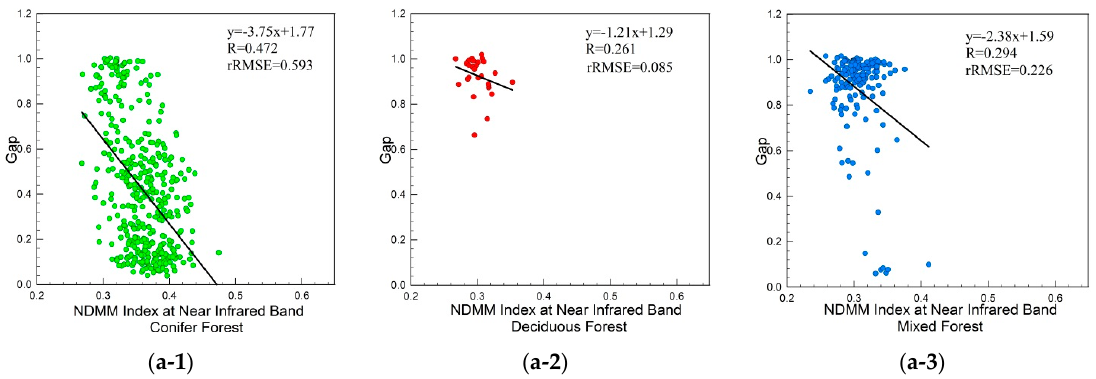
Figure 9. Relationship between the gap fraction and NDMM index at near-infrared band for three kinds of forests in Howland. ( a-1 ), ( a-2 ) and ( a-3 ) represent the relationship between the gap fraction and NDMM Index at near-infrared band for the conifer, deciduous, and mixed forests respectively.